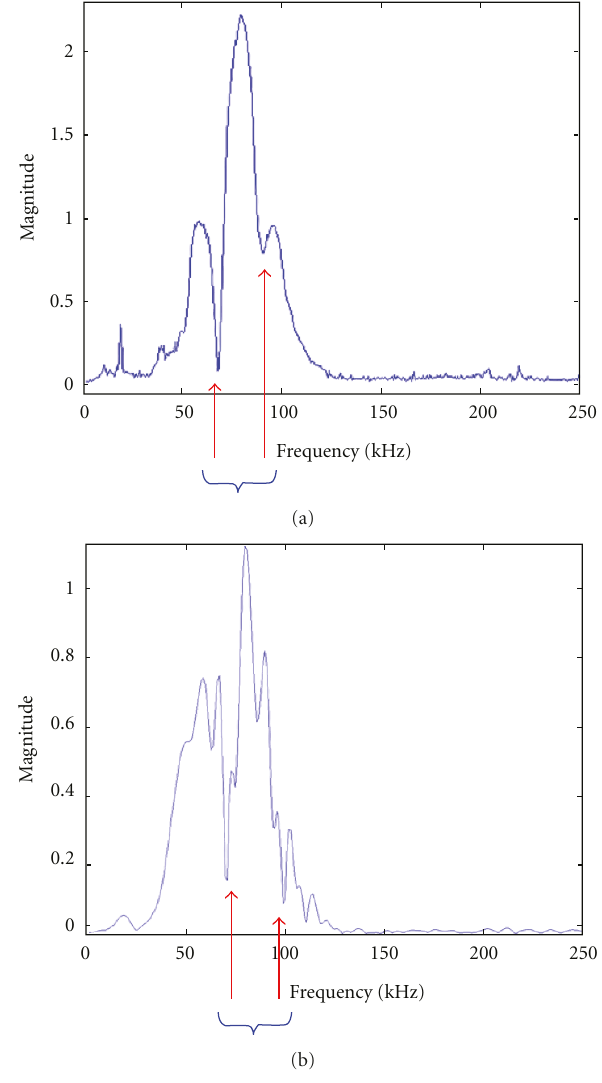
Figure 15: Cable responses: (a) free water, linear FM pulse; (b) DC pulse, cable lying on tank floor. Red arrows indicate model predictions for locations of key spectral